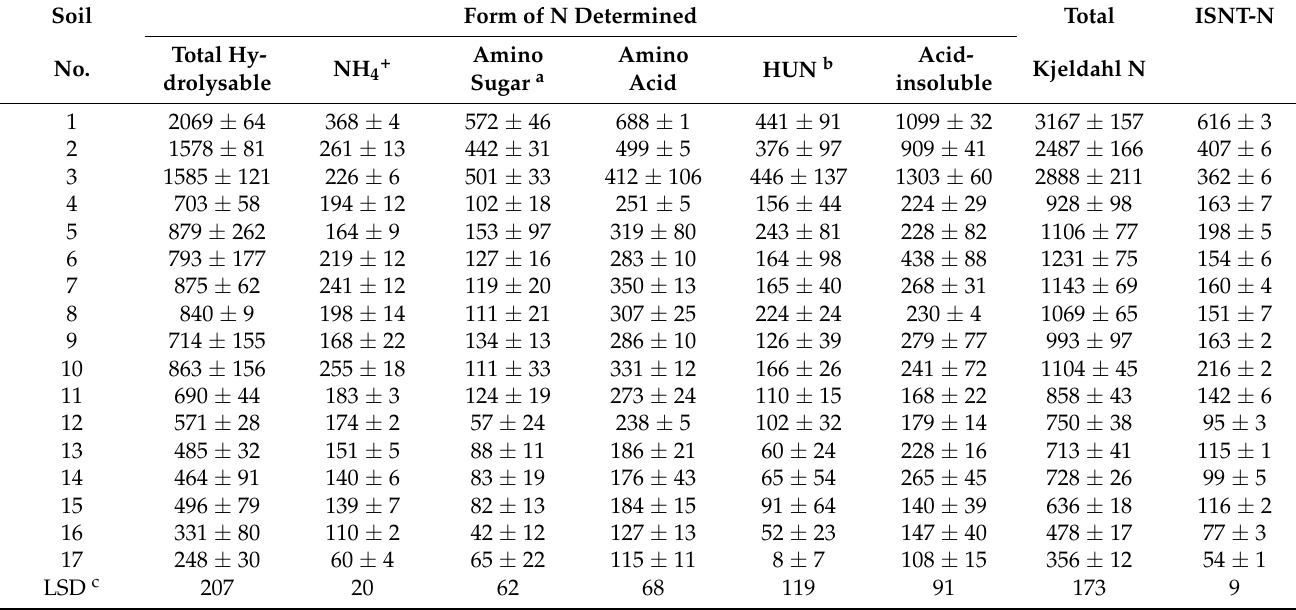
Table 4. Concentrations (mg kg − 1 ) of hydrolysable N and potentially available N estimated by the Illinois Soil Nitrogen Test (ISNT) for the soils studied. Data reported as a mean ± standard deviation (4 replicates).